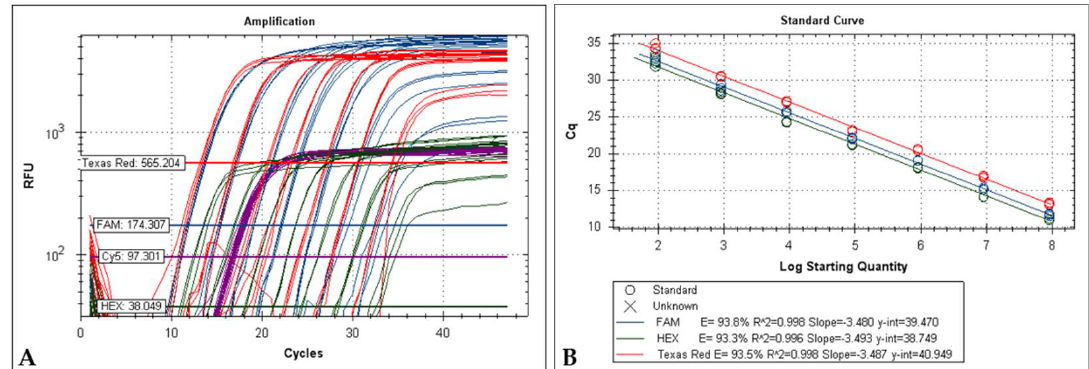
Figure 3. ( A ) Serial dilution from 9.0 × 10 7 to 9.0 × 10 1 copies of each plasmid (pM000.5L/R, pM009L and pM060L) and a constant 3 × 10 6 copies of p18S per reaction. Red curves (TexRed) correspond to m060L system, blue curves (FAM) corresponding to m000.5L/R system, green curves (HEX) corresponding to m009L system and purple curves (CY5) correspond to 18S system. ( B ) Standard curve for the quadruplex qPCR. The reaction copies ranged from 9.0 × 10 7 to 9.0 × 10 1 copies in the final reaction.